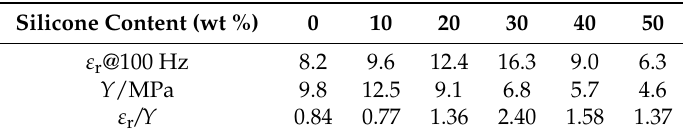
Table 2. Electromechanical efficiency of the